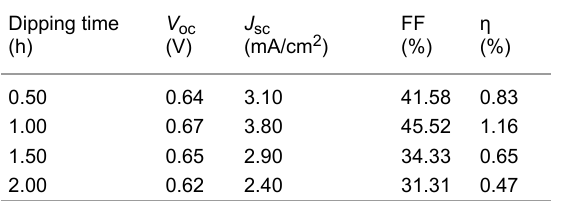
Table 6: J–V characteristics of ZnO/Au-nanocomposite DSSCs with increasing amount of Au nanoparticles in the photoelectrode as a